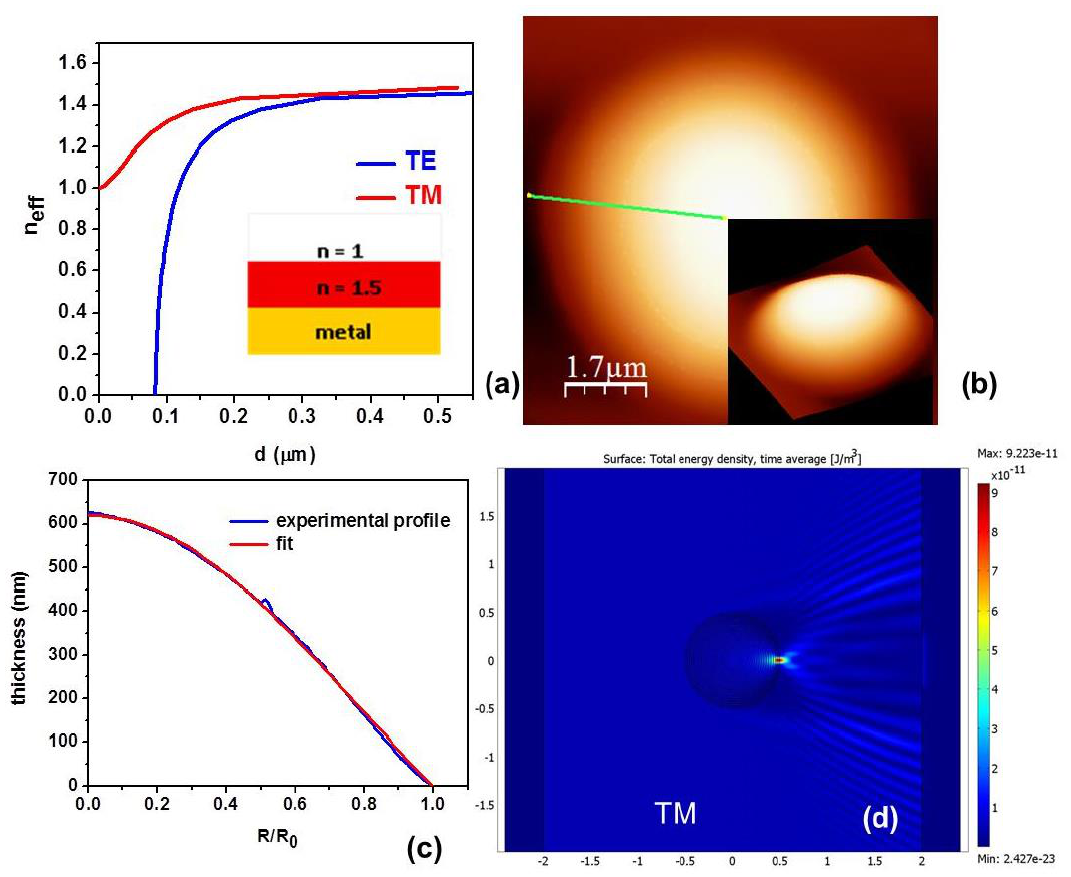
Figure 1. ( a ) Calculated effective refractive index for the TM and TE light as a function of thickness d of the dielectric layer deposited onto the surface of ideal metal. The inset shows the dielectric waveguide geometry. ( b ) Atomic force microscope (AFM) image of the fabricated Luneburg lens. The inset shows 3D representations of the shape. ( c ) Measured photoresist thickness variation of the lens shown in (b) along the green line fitted to a modified Luneburg lens described by Equation (5). The fit is shown in red. ( d ) Theoretical simulation of a waveguide-based Luneburg lens for TM polarized light using COMSOL Multiphysics. The lens diameter in the simulation is set to